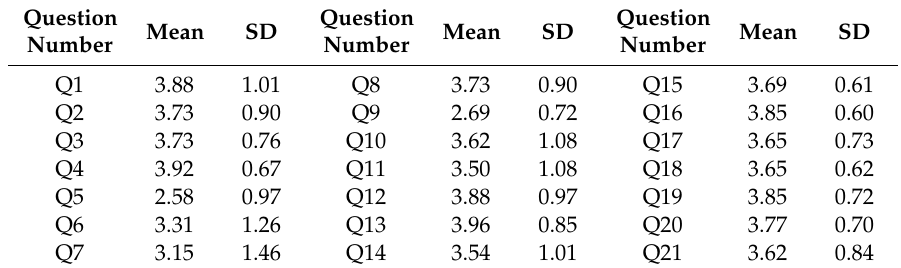
Table 11. Questionnaire findings. Scale: 5 = Strongly Agree; 4 = Agree; 3 = Neutral; 2 = Disagree; 1 = Strongly